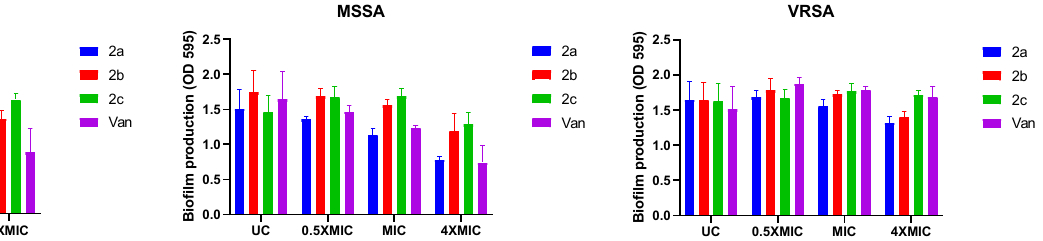
Figure 3. The activity of compounds 2a – c on the Staphylococcus aureus biofilm integrity. The S. aureus biofilms were exposed with increasing concentrations of compounds 2a – c or vancomycin (Van) for 24 h. After exposure with the test compounds, the biofilm integrity was evaluated by crystal violet assay. Data provided in the graphs are mean ± SD from 3 experimental replicas.